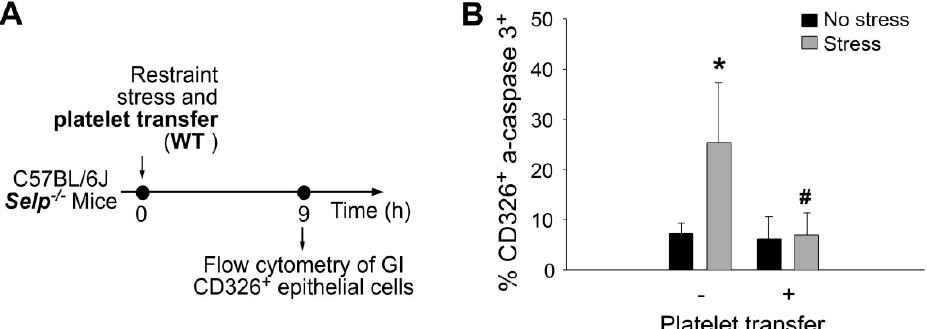
Figure 8. Stress-induced apoptosis of GI CD326 + epithelial cells are rescued by platelet transfer in mice. ( A ) Experiment outline of restraint stress mouse model. ( B ) Flow cytometry analysis of GI CD326 + epithelial cells from Selp − / − mice with or without stress, and with or wild-type (WT) platelet transfer. CD326: epithelial cell marker; active-form caspase 3 (a-caspase 3): apoptotic cell marker. * p < 0.05 vs. no stress groups; # p < 0.05 vs. without platelet transfer groups. n = 6 (three experiments with total six mice per group).